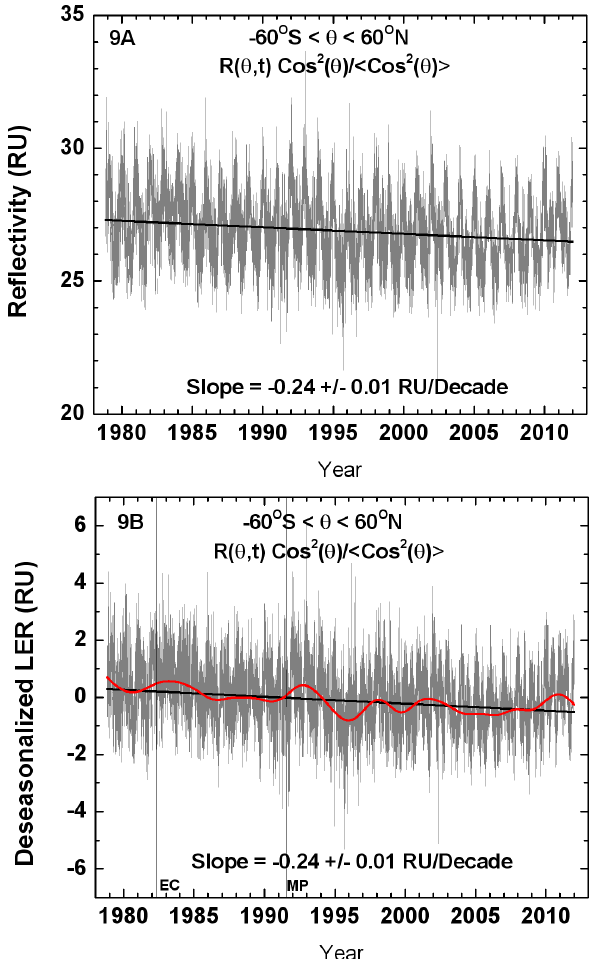
Fig. 9. (A) Normalized cos 2 (θ) weighted zonal average reflectiv- ity for θ =60 ◦ S to 60 ◦ N, (B) normalized deseasonalized LER( θ , t ) cos 2 (θ) for θ =60 ◦ S to 60 ◦ N. The dark solid line is a 365- day low-pass filter showing the major multiyear cycles. Normal- ization in equation 2 is < cos 2 (θ)> =0.707. EC=El Chichon and MP=Mt.